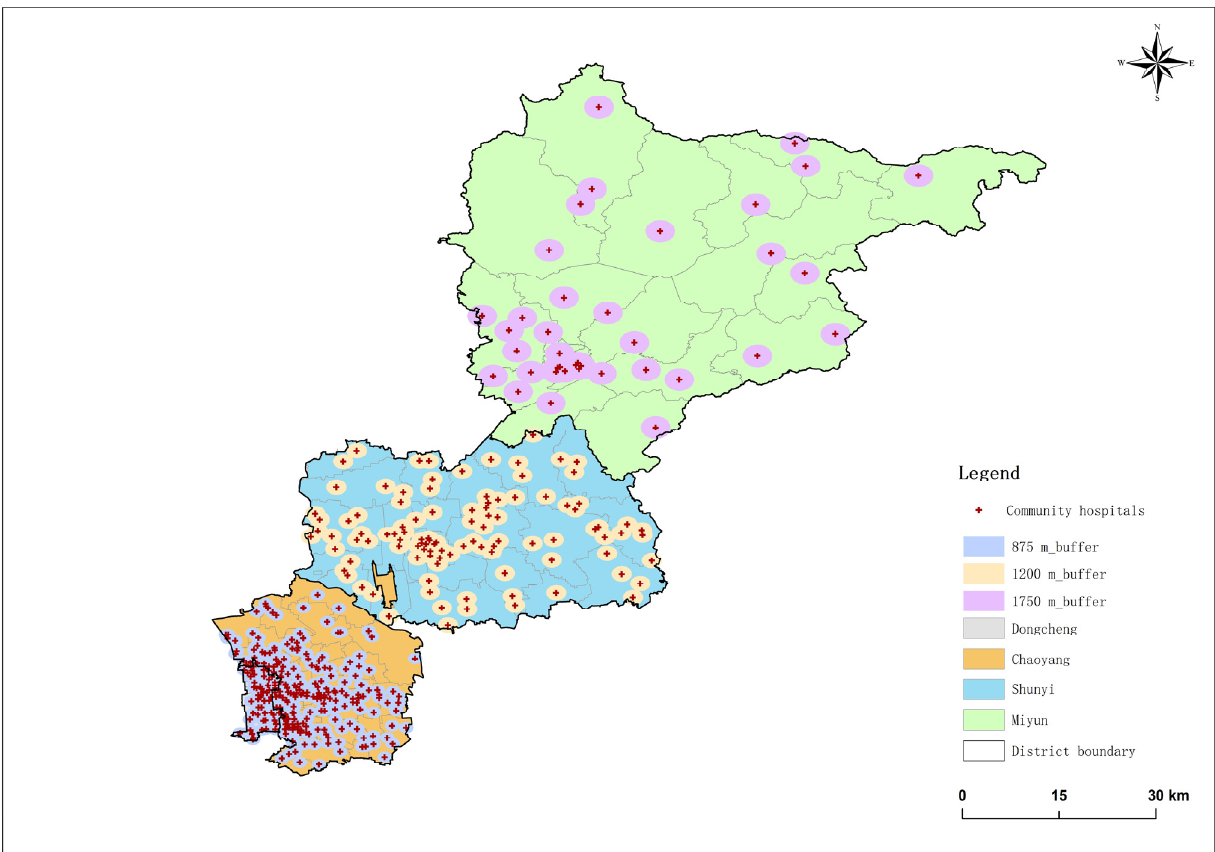
Figure 3. Walking distances to community hospitals in four districts.